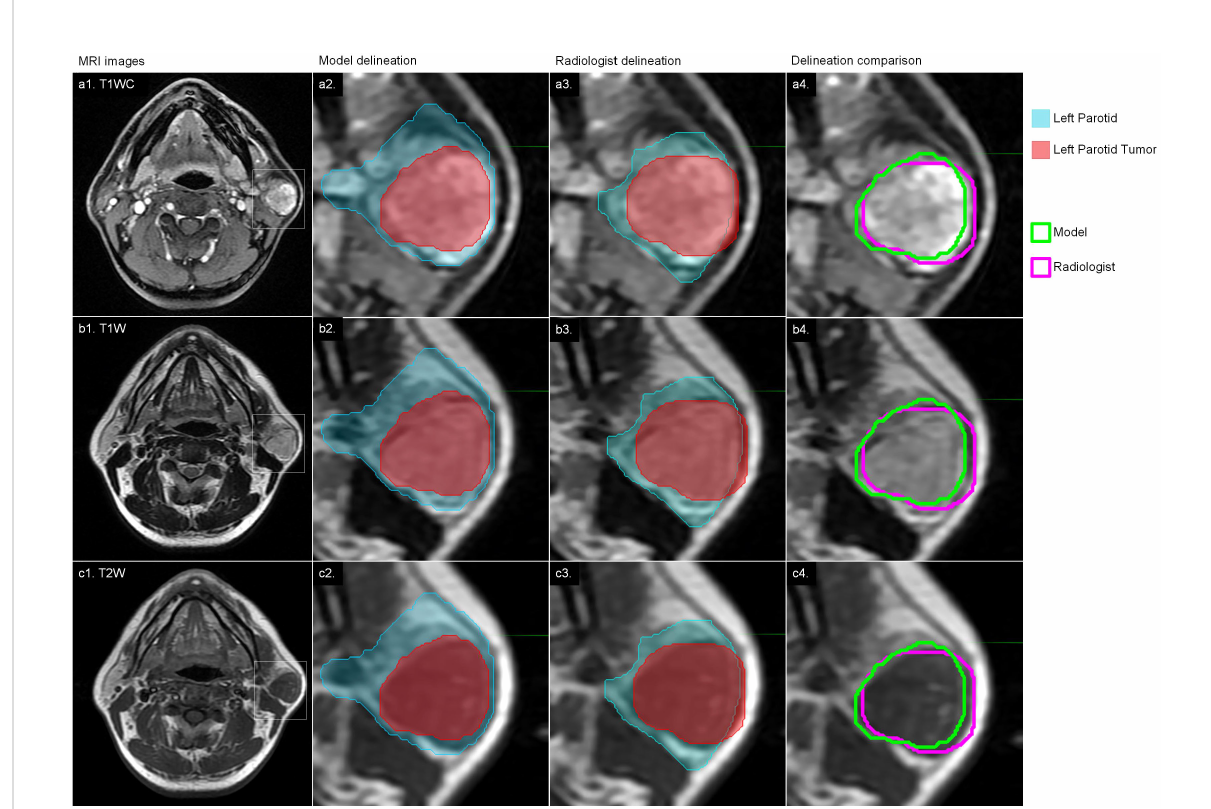
FIGURE 4 An example of the results. a1, b1 and c1 represent one slice of the MR images; a2, b2 and c2 represent the results of autosegmentation; a3, b3 and c3 represent the results of manual segmentation; a4, b4 and c4 show the comparison of the tumor